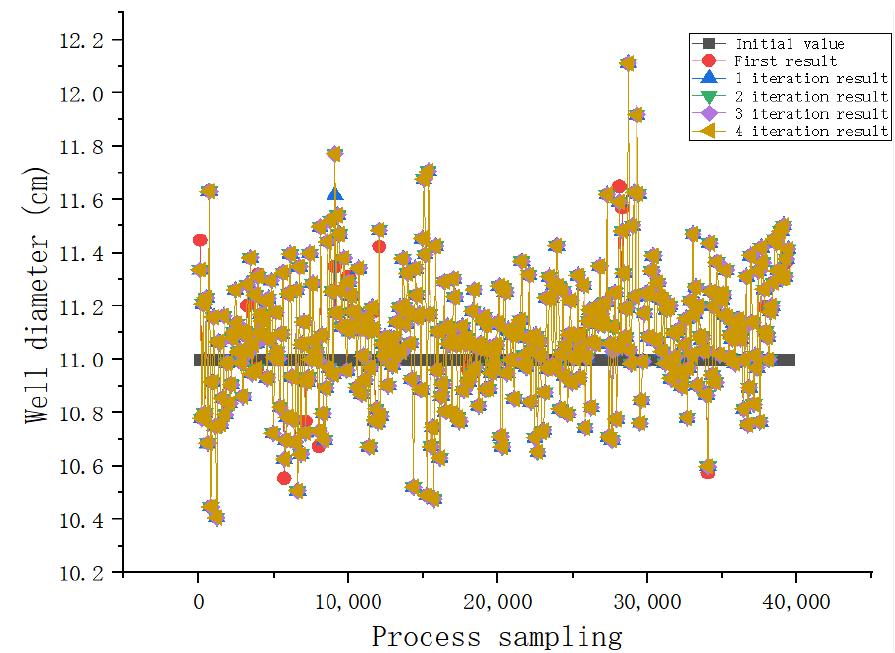
Figure 11. Relationship between interpolation and multiple iterations.